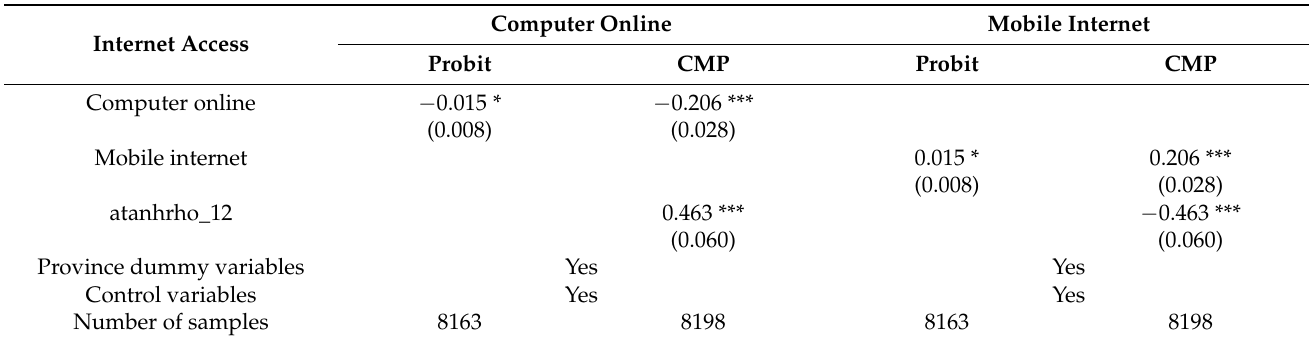
Table 6. Regression results of internet access